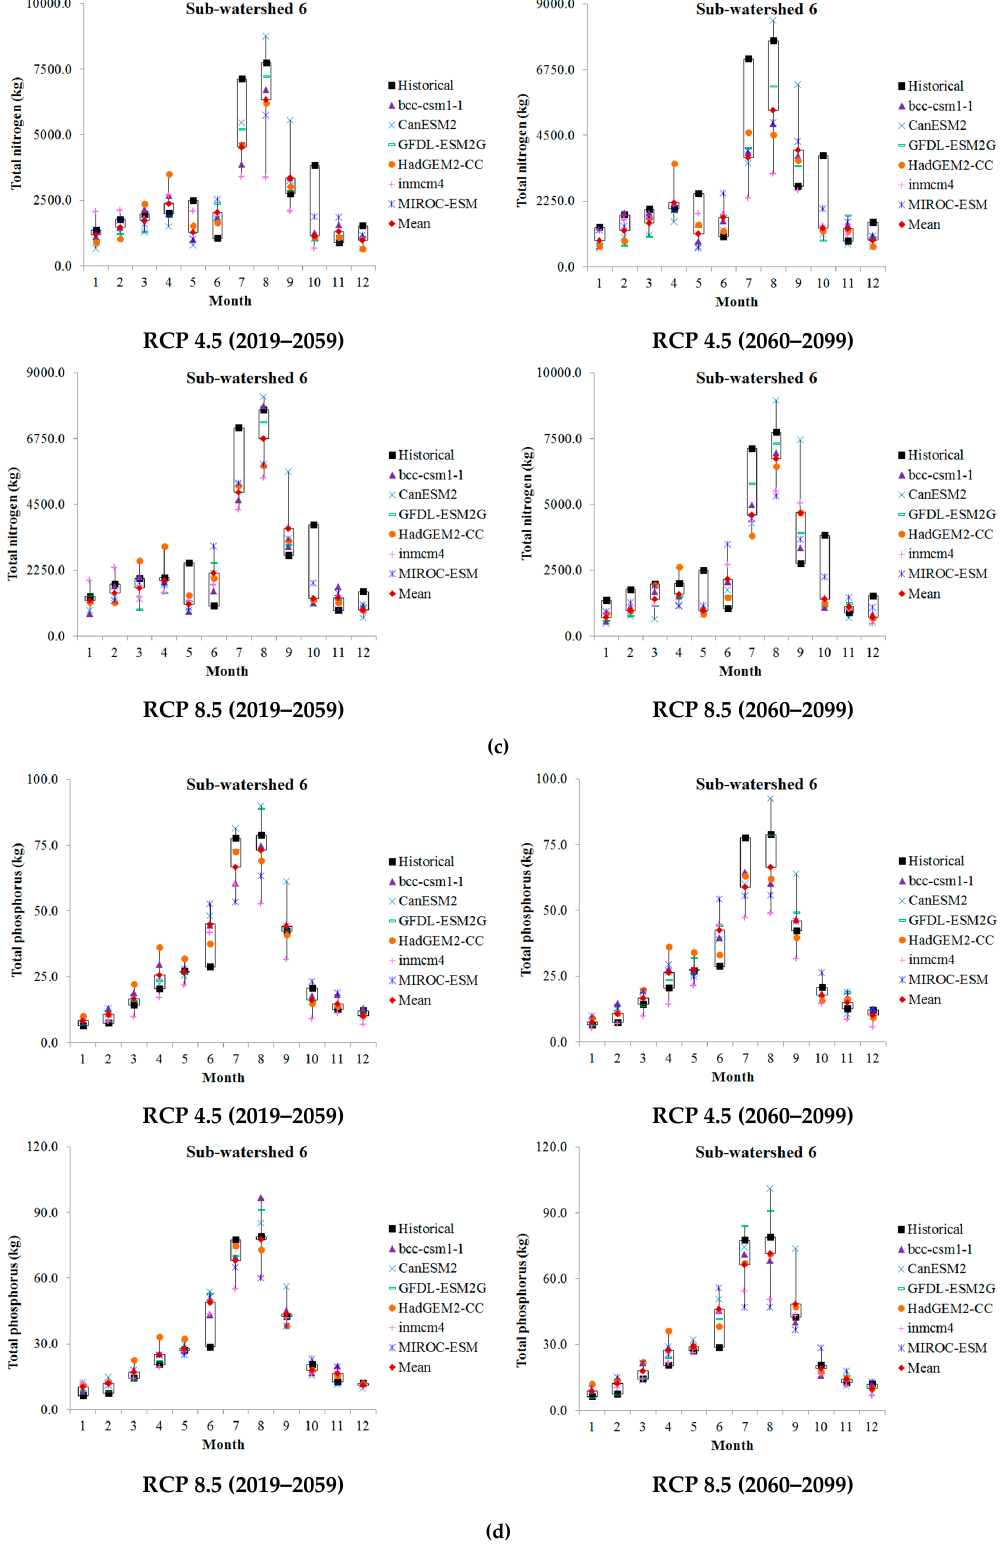
Figure 8. The ranges in future monthly ( a ) streamflow, ( b ) sediment, ( c ) TN load, and ( d ) TP load for Sub-Watershed-6 the Saemangeum watershed under the representative concentration pathway (RCP) climate change scenarios compared with the